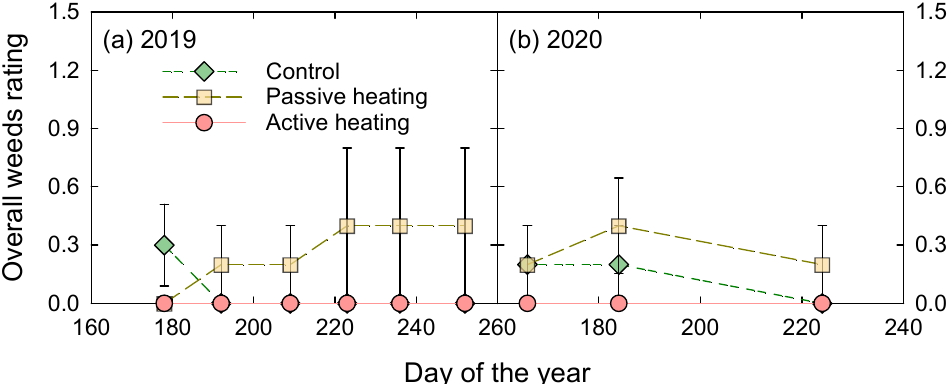
Figure 7. Warming impact on weeds. The incidence of overall weeds of the wild blueberry fields under different treatments in 2019 the prune year ( a ), and in 2020 the crop year ( b ). Data are means ± SEs. Green diamonds with short dashed lines denote the ambient control plots (CON), yellow squares with long dashed lines are passive-heating (PH) OTCs, while red circulars with solid lines indicate the active-heating (AH) OTCs. No significant differences were detected among the treat- ments ( p > 0.05).